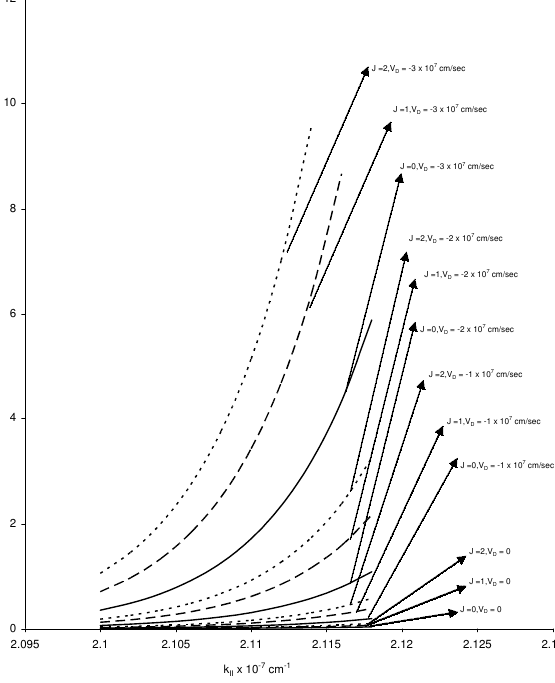
Fig. 3. Variation of parallel resonant energy W rII ergcm versus wave vector k II cm − 1 for different values of ion beam V D , and distribution index J =0, 1, 2, A Fig.3 Variation of parallel resonant energy W rII erg cm versus wave vector k II cm -1 for different values of ion beam velocity V D , and distribution index J=0,1,2, A=15